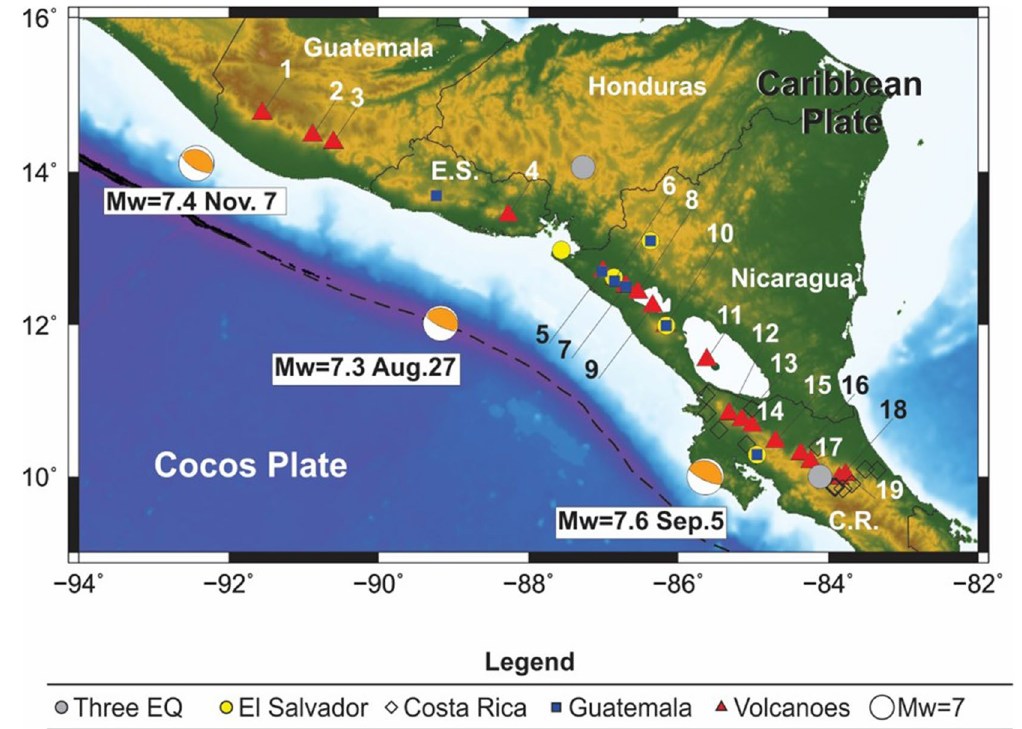
Figure 1. Epicenter of the 2012 earthquakes, volcanoes in states of unrest, and location of the seismic stations used to obtain the waveforms for calculating the dynamic stress of the earthquakes in Central America (more information in the Supplementary Material). The dashed line corresponds to the Meso-American trench along which the Cocos plate is subducting below the Caribbean plate. Grey circles indicate the seismic stations available for the three earthquakes in 2012 (August 27, El Salvador; September 5, Costa Rica; November 7, Guatemala). The yellow circles, black diamonds, and blue squares indicate the seismic stations that generated information for the El Salvador, Costa Rica and Guatemala earthquakes, respectively. The orange/white circles are the focal mechanism of each earthquake from Global CMT. The volcanoes analyzed in this study are: 1. Platanar, 17. Poás, 18. Irazú and 19. Turrialba. Figure created in Generic Mapping Tools (GMT; https:// www. gener ic- mappi ng- tools.